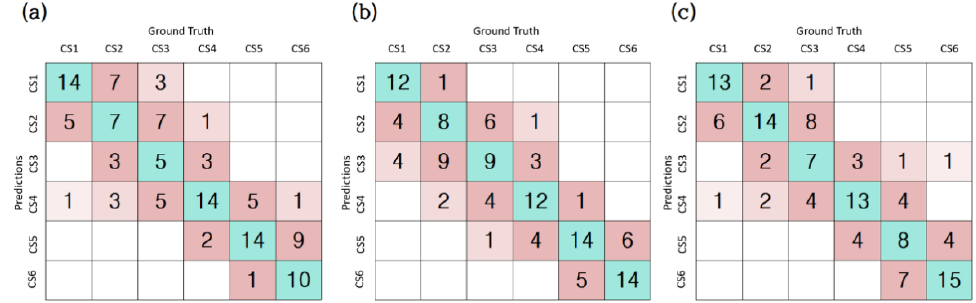
Figure 7. ( a ) Confusion matrix of model_1; ( b ) confusion matrix of model_2; ( c ) confusion matrix of model_3.